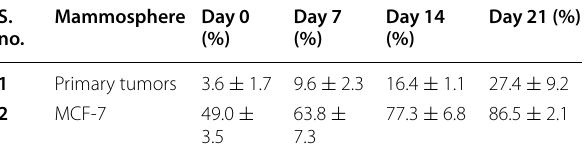
Table 4 CD44 + /CD24 − stem-like cell population in mammospheres from primary breast tumors and MCF-7 cell line S. no.